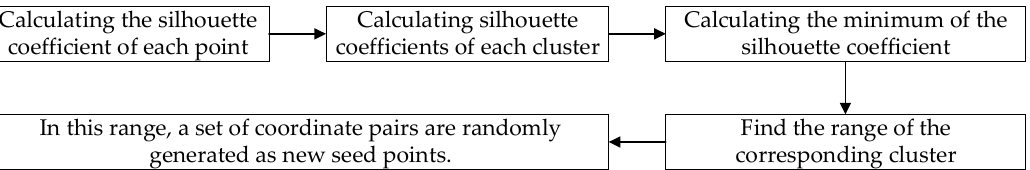
Figure 4. SSE inflection point recognition considering silhouette coefficient.